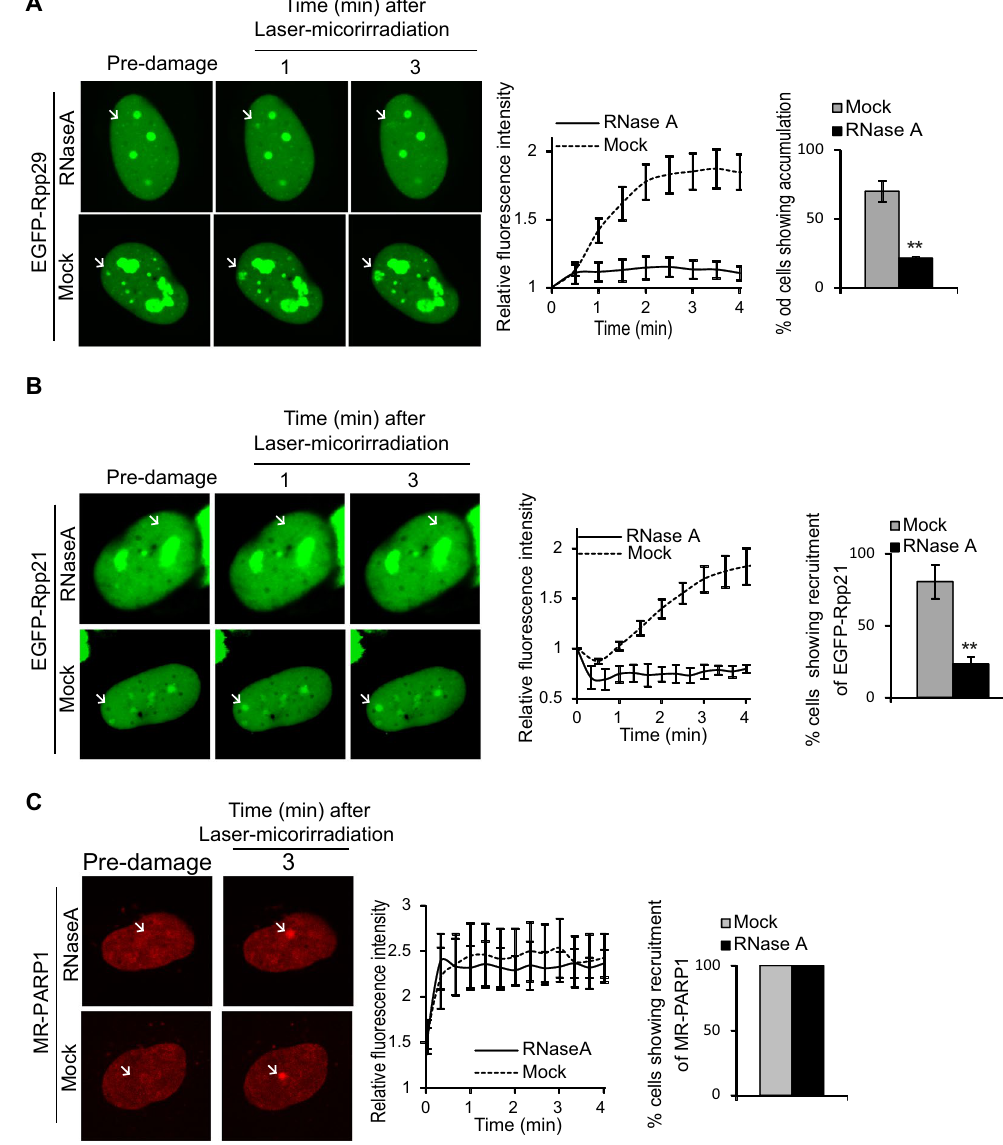
Figure 6. RNase A treatment of cells disrupts the recruitment of EGFP-Rpp29 and EGFP-Rpp21 to laser microirradiated sites. ( A , B ) Representative time-lapse images (left) of mock- and RNase A-treated U2OS cells showing the localization of EGFP-Rpp29 ( A ) and EGFP-Rpp21 ( B ) at the indicated times after laser- microirradiation of a single region marked by white arrow. Results shown are typical of three independent experiments and represent at least 30 different cells. Graphs (middle) show the increase in the relative fluorescence intensity of EGFP-Rpp29 and EGFP-Rpp21 at laser-microirradiated sites in mock and RNase A-treated cells. Each measurement is representative of at least 10 cells. Error bars indicate SD. Graphs (right) display the percentage of RNase A-treated cells showing subcellular distributions of EGFP-Rpp29 and EGFP- Rpp21, as compared with those seen in untreated cells. Error bars depicts the SEM from two independent experiments. P-values were calculated by two-sided Student’s t-test relative to DMSO; ** p < 0.01. ( C ) As in A, except for that the laser microirradiation was applied on U2OS cells expressing MonomerRed-PARP1 (MR-